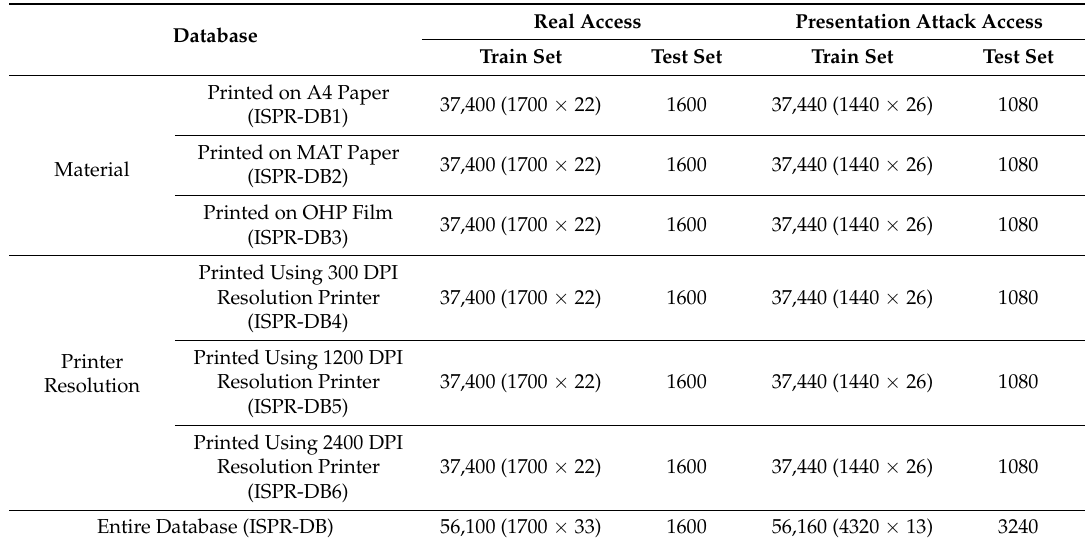
Table 9. Description of the augmented database derived from ISPR database and its sub-databases